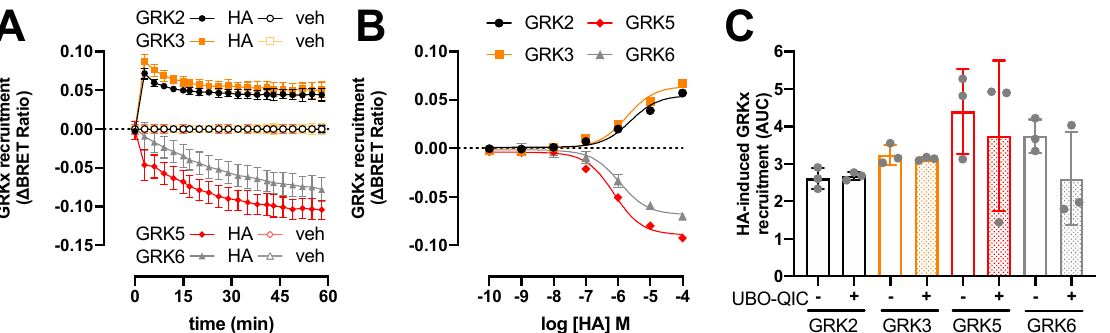
Figure 3. Histamine (HA)-induced modulation in H 1 R interaction with GRKs. BRET measurements in HEK293T cells transiently co-expressing H 1 R-Rluc8 (0.5 µg plasmid/dish) in combination with GRK2-mVenus, GRK3-mVenus, GRK5-mVenus, or GRK6-mVenus (4.0 µg plasmid/dish) in real time upon stimulation with 10 µM histamine ( A ) or after 1-h stimulation with increasing concentrations histamine ( B ). Data are shown as mean ± SD from at least three independent experiments performed in triplicate. Area under the curve (AUC) of 1-h BRET traces in response to 10 µM histamine following 30-min pretreatment of the cells with vehicle (control) or 1 µM UBO-QIC. AUC of the BRET experiments are presented as mean ± SD from three independent experiments performed in triplicate, with scatter plots (gray dots) showing the individual AUC values ( C ). No statistical differences ( p < 0.05) compared to vehicle-pretreated (i.e., control) cells are observed using one-way ANOVA with Dunnett’s multiple comparison test.